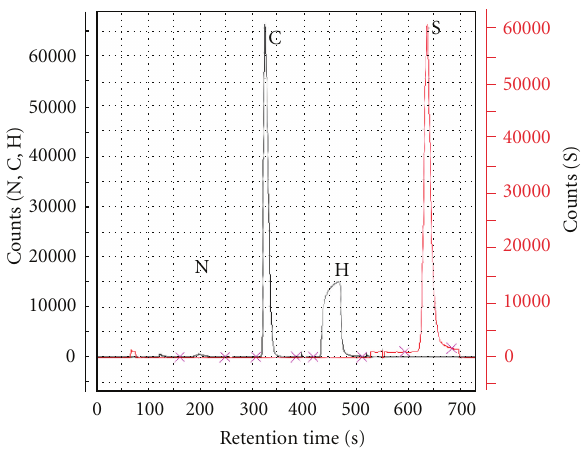
Figure 1: Typical elemental analyzer chromatogramofECD in ECD